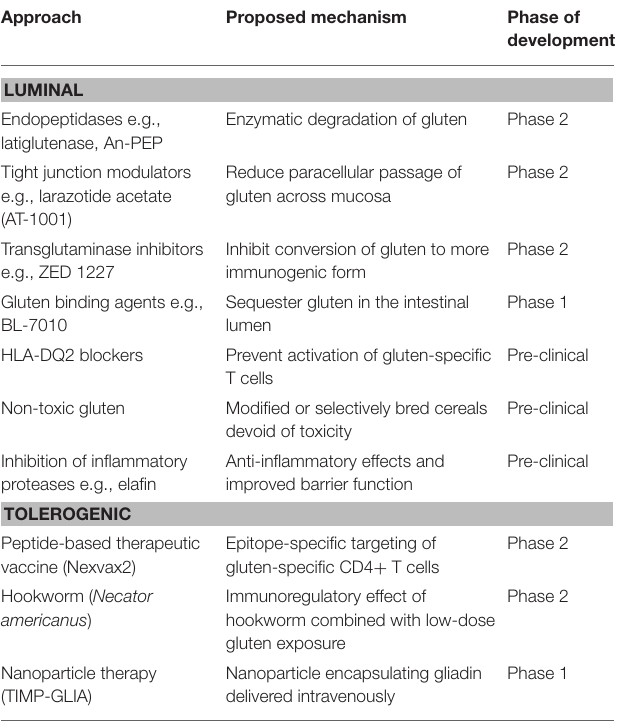
TABLE 3 | Experimental therapies for celiac disease in pre-clinical or clinical development.